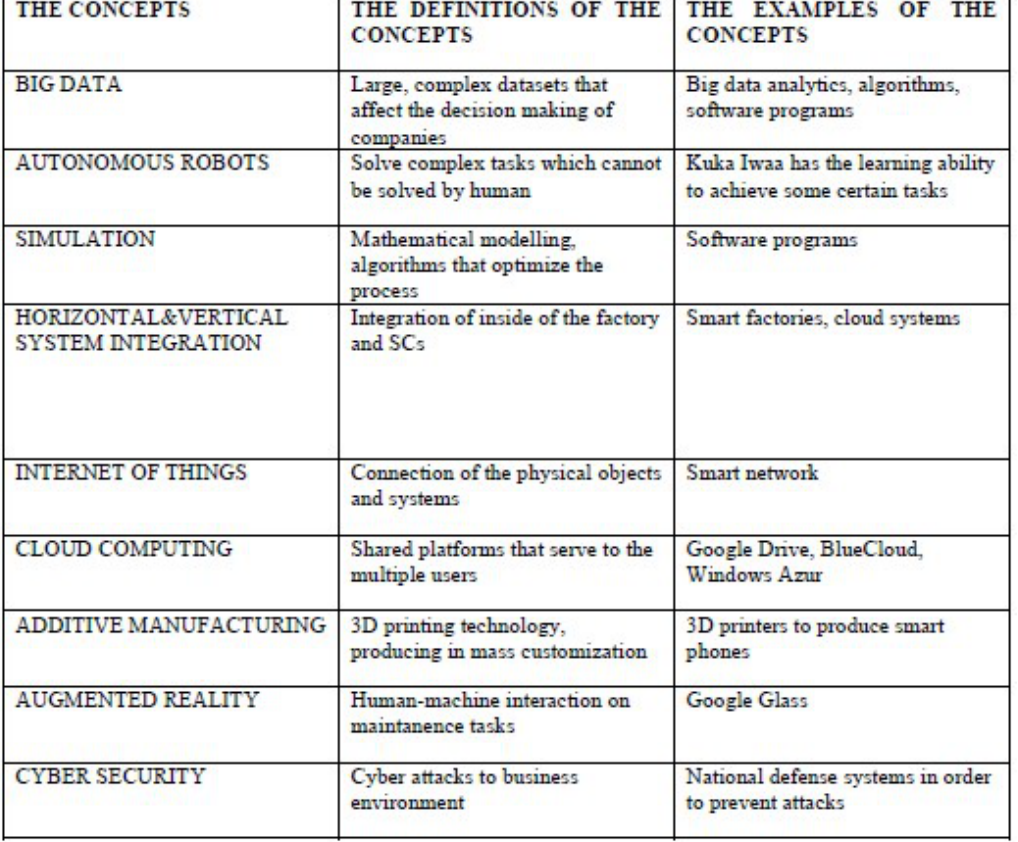
Table 1. Future of Industry